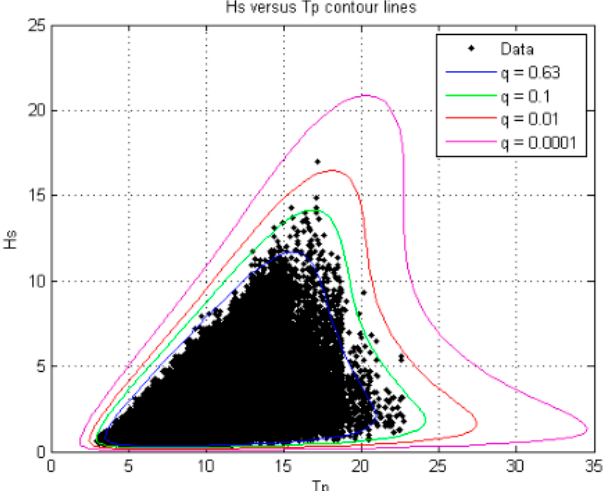
Figure 2. Environmental contour lines for Haltenbanken [6], q is the annual probability of exceedance. Reproduced from [6]: Haver, S.; Bruserud, K.; Baarholm, G.S. Environmental Contour Method: An Approximate Method for Obtaining Characteristic Response Extremes for Design Purposes. Statoil, DNV, 2012 with permission from lead author Haver, 2020,The description of the wave event of 12 March 1995 can be summarized as follows: The wave event was forecasted by the Aberdeen Weather Center. There had been strong winds for a longer period and the wind during the event was strong with hurricane gusts. The platform was hit by two consecutive waves which caused the platform to oscillate (in “a ringing event”) for half a minute to one minute due to the impact load. The water splashed with large forces into the cellar deck removing fish hanging for drying under the deck and displacing fiberglass boxes that were strapped to the deck 30 m above the still water